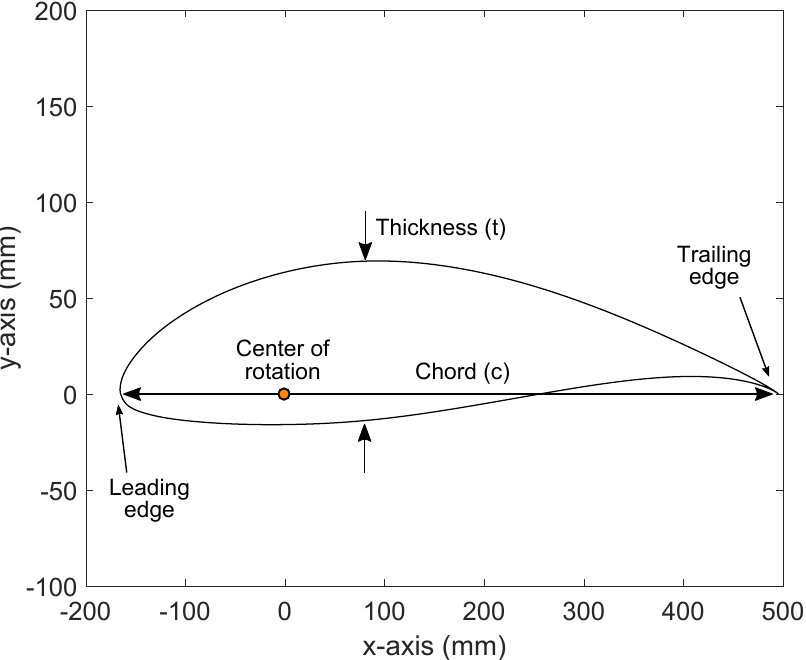
Figure 1. Graphical representation of the foil profile at r / R blade = 0.99 radial location